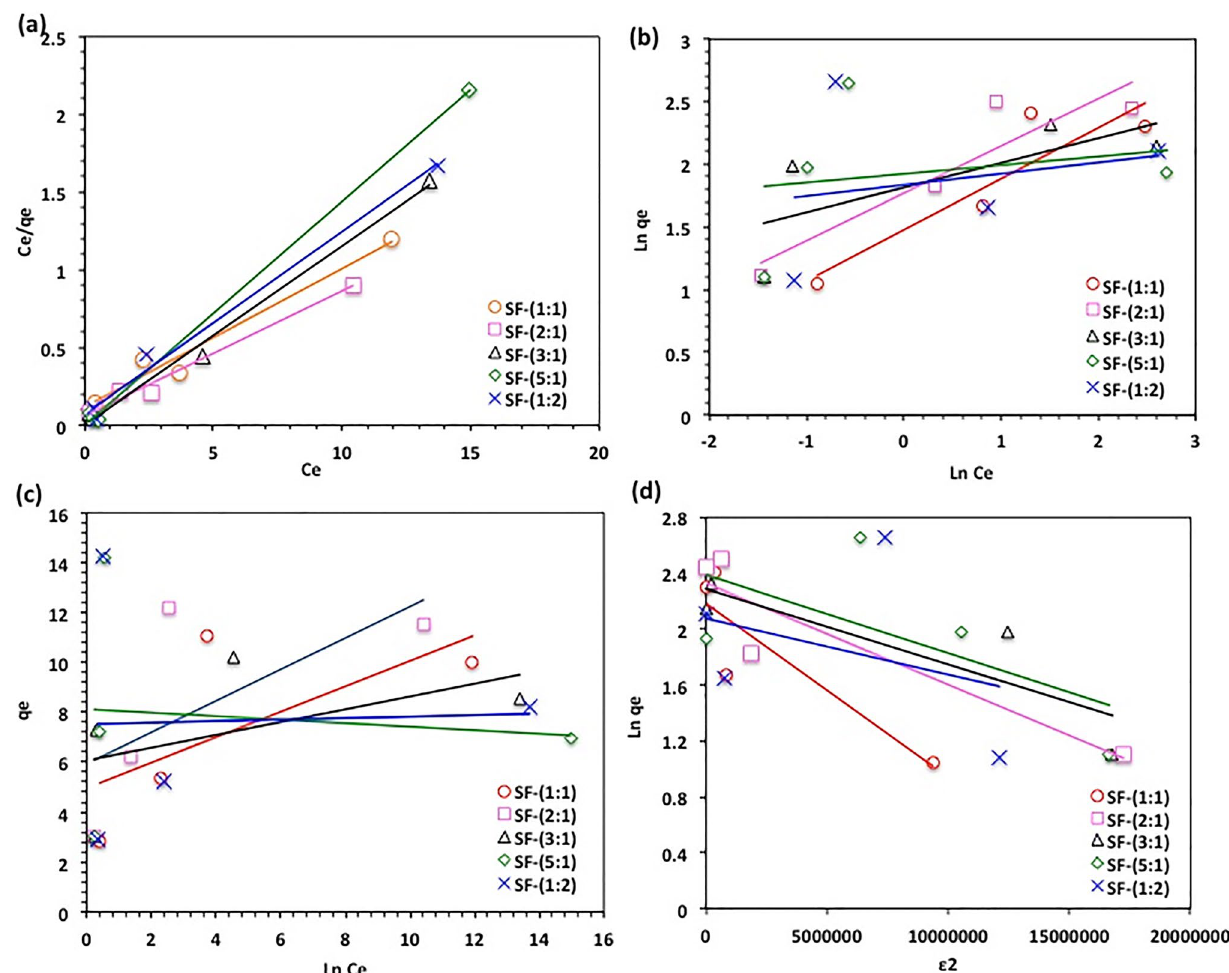
Fig. 9 Linearized adsorption isotherms for FS-material a Langmuir, b Freundlich, c Temkin, d D-R